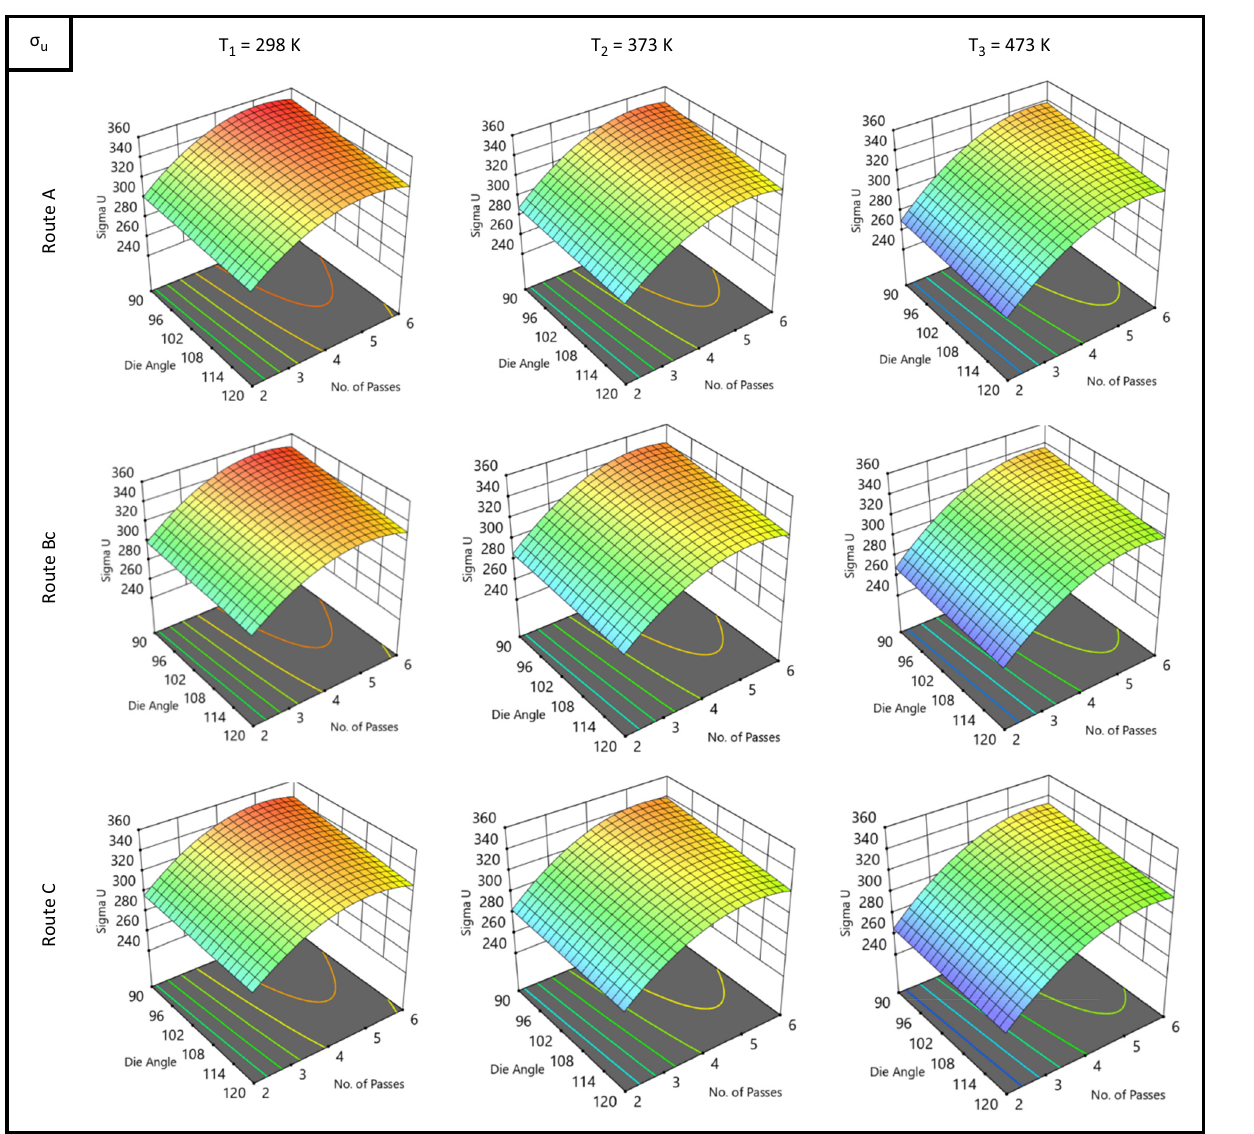
Figure 15: Response surface plot of σ u as a function of die angle, number of passes, route type, and processing